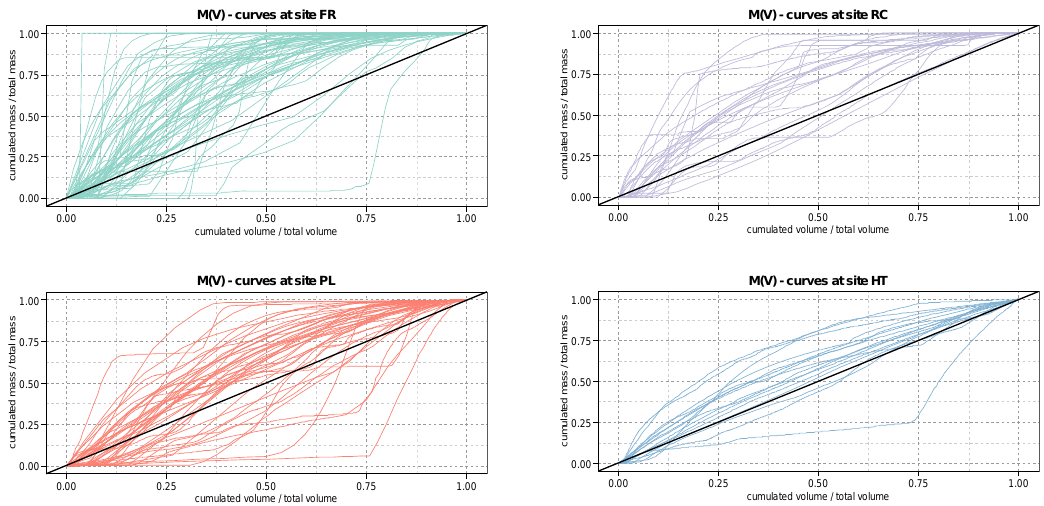
Figure 2. Site-specific M ( V )-curves (FR: flat roof, RC: residential catchment, PL: parking lot, Figure 2. Site ‐ specific M ( V ) ‐ curves (FR: flat roof, RC: residential catchment, PL: parking lot, HT: high ‐ HT: high-traffic traffic street).